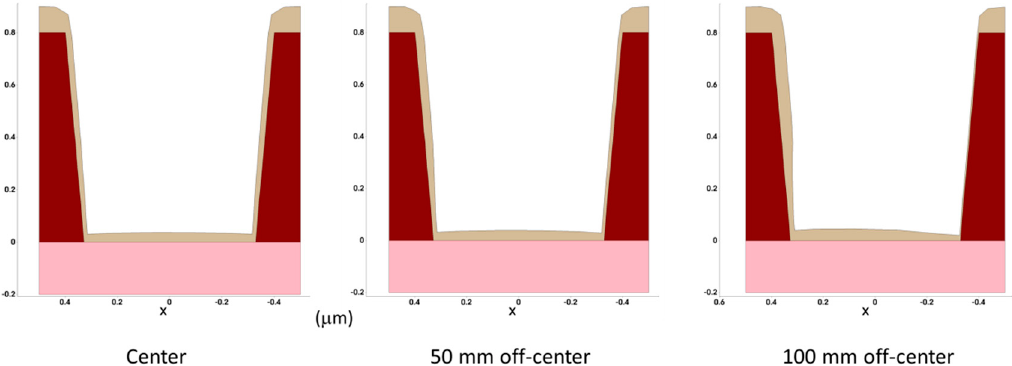
Figure 10. Example for the simulation of long-throw sputter deposition into a contact hole structure for different positions on the wafer. Ballistic transport of the metal atoms in the reactor is assumed, the target diameter and the distance between target and substrate were set to 300 mm and 150 mm, respectively. The step coverage (= ratio of the thickness at the sidewall bottom to the thickness on top) for the feature position at the center, 50 mm off-center, and 100 mm off-center is here given for left | sidewall right: 0.16 | 0.16, 0.16 | 0.12, and 0.20| 0.05, sidewall left | sidewall right: 0.16 | 0.16, 0.16 | 0.12, and 0.20 | 0.05, respectively.